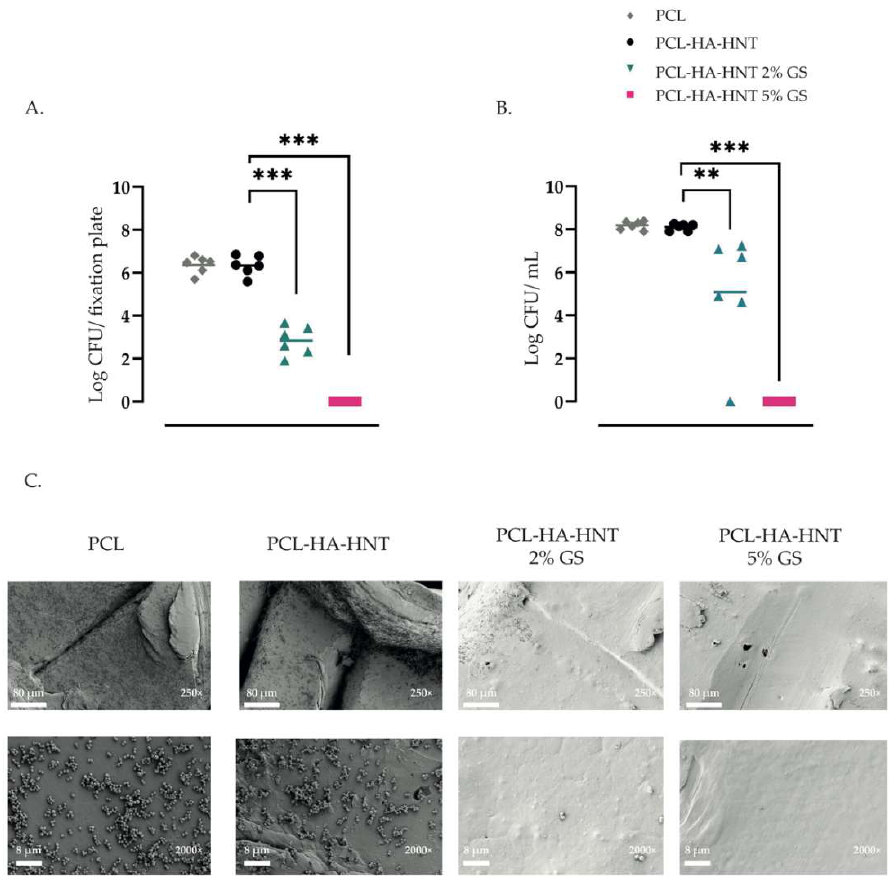
Figure 8. In vitro antimicrobial activity of PCL, PCL-HA-HNT, PCL-HA-HNT 2% GS and PCL-HA- HNT 5% GS fixation plates, as characterized by numbers of attached S. aureus CFU cultured from the plates ( A ), and bacterial growth in the medium ( B ) after inoculation with 10 6 CFU/mL, and by visualization of bacteria attached to the surface of the fixation plates by SEM ( C ). n = 6 replicates per group. ** Indicates a p -value of 0.001 to 0.01, *** p -value of 0.0001 to 0.001.